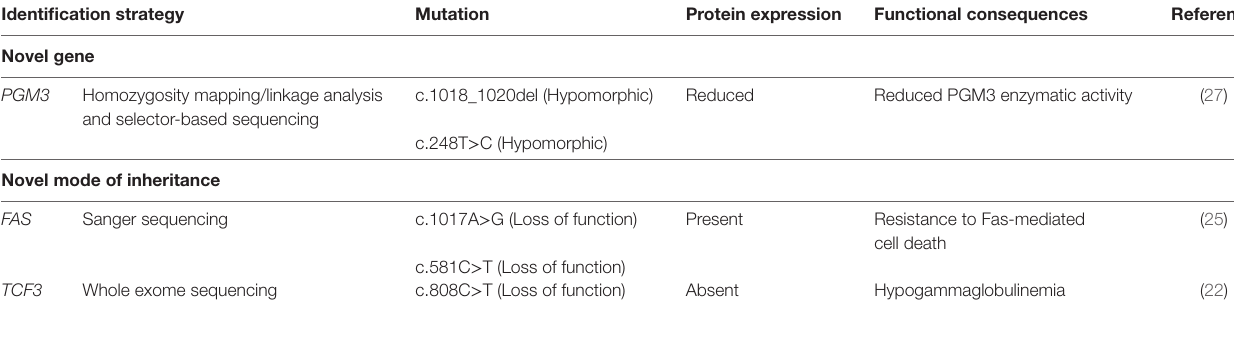
TABLe 2 | Identification of novel gene and novel mode of inheritance for known genes in Tunisian consanguineous families. identification